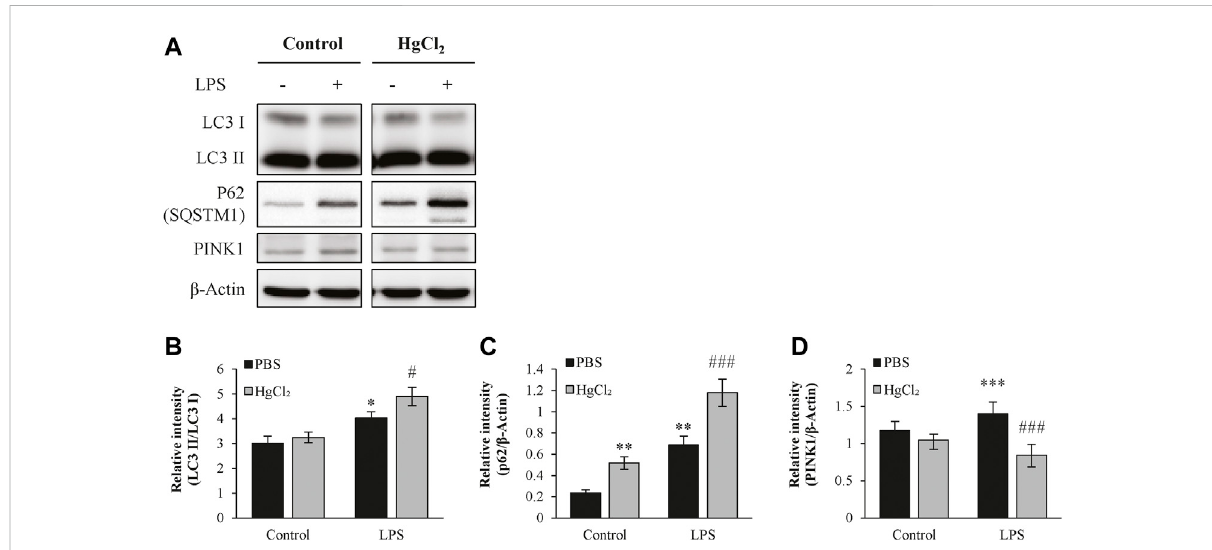
FIGURE 6 HgCl 2 upregulates the autophagy in M1 bone marrow-derived macrophages (BMDMs). (A) Autophagy of BMDMs 8 h after LPS (1 μ g/ml) and HgCl 2 (1 μ M) treatment was determined by western blot analysis and (B – D) interpreted by semi quantitative densitometric analysis ( n = 4 – 6). Ba fi lomycin A1 (100 nM) were cotreated with LPS to normalize autophagy fl ux. Values are mean ± SEM. * p < 0.05 vs. control. ** p < 0.01 vs. control. *** p < 0.001 vs. control. # p < 0.05 vs. LPS. ### p < 0.001 vs. LPS.